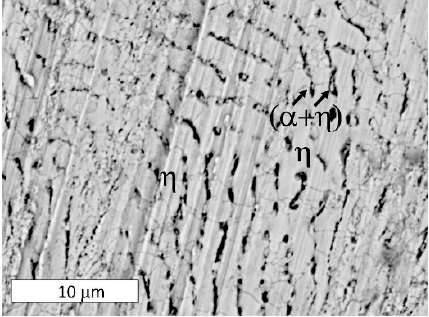
Figure 8. SEM image of the surface of a sample after polarization up to a potential of +225 mV vs. E corr . Selective dissolution of the eutectoid ( α + η ) in eutectic areas of the Zn-4Al alloy is visible.